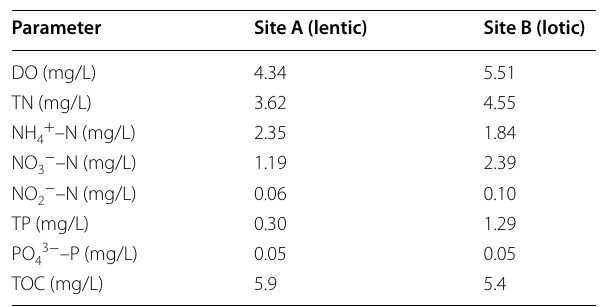
Fig. 2 The effects of sampling time, Site (A substrate type on the number of surface-associated